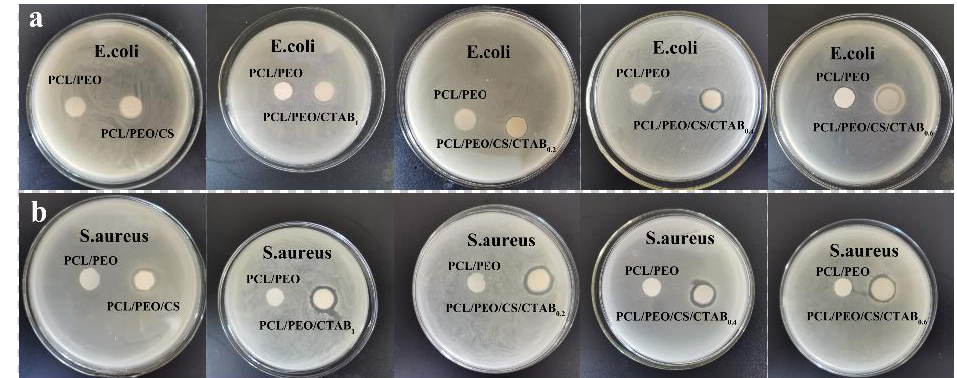
Figure 7. Images of the qualitative inhibition circle of composite films: ( a ) E. coli ; ( b ) S. aureus .